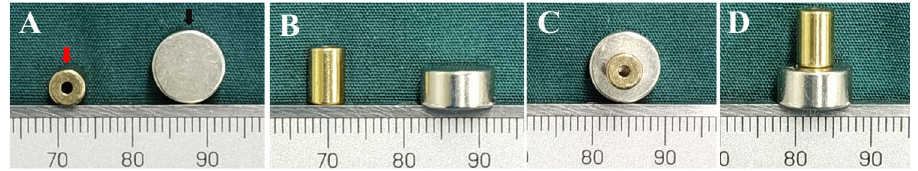
Figure 1. Photographs of the daughter magnet and the parent magnet. ( A ) Bottom view of daughter magnet (red arrow) and parent magnet (black arrow). ( B ) Side view of the magnets. ( C ) Bottom view of the two magnets attracted together. ( D ) Side view of the two magnets attracted